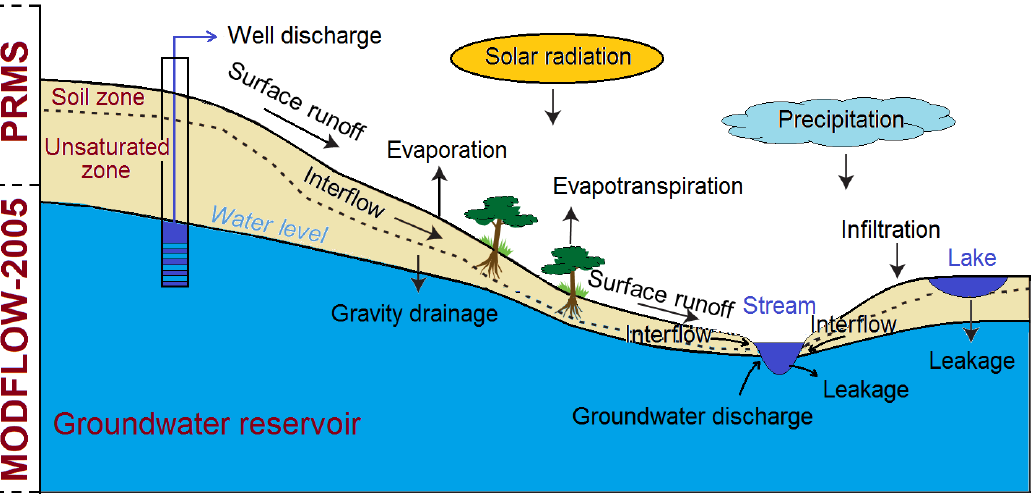
Figure 2. The three regions for the GSFLOW model, including the plant canopy and the soil zone, the streams and lakes, and the unsaturated zone and the aquifer system (Modified from [11]).